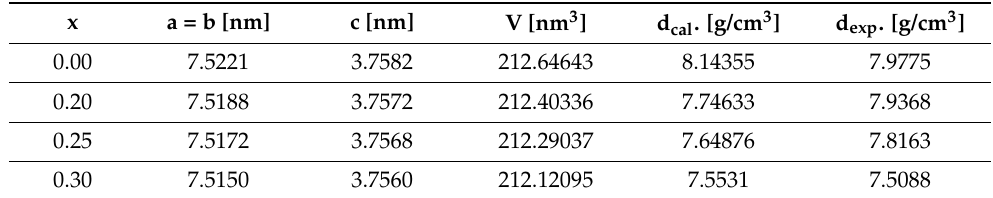
Table 3. Unit cell parameters and volumes for the CuTa 2 O 6 (x = 0) and solid solution CuTa 2 − x V x O 6 for x = 0.20, 0.25 and 0.30.